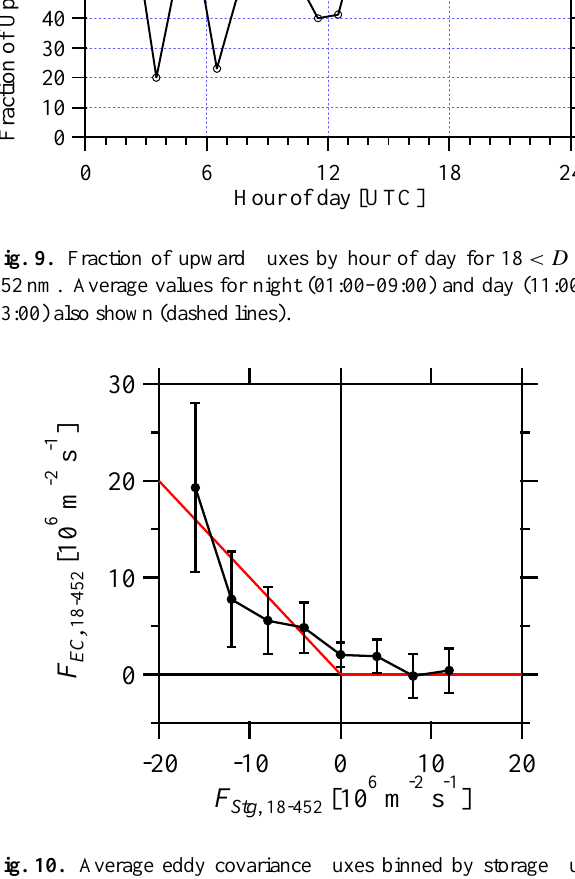
particles. Error bars show the 95% confidence interval. 3